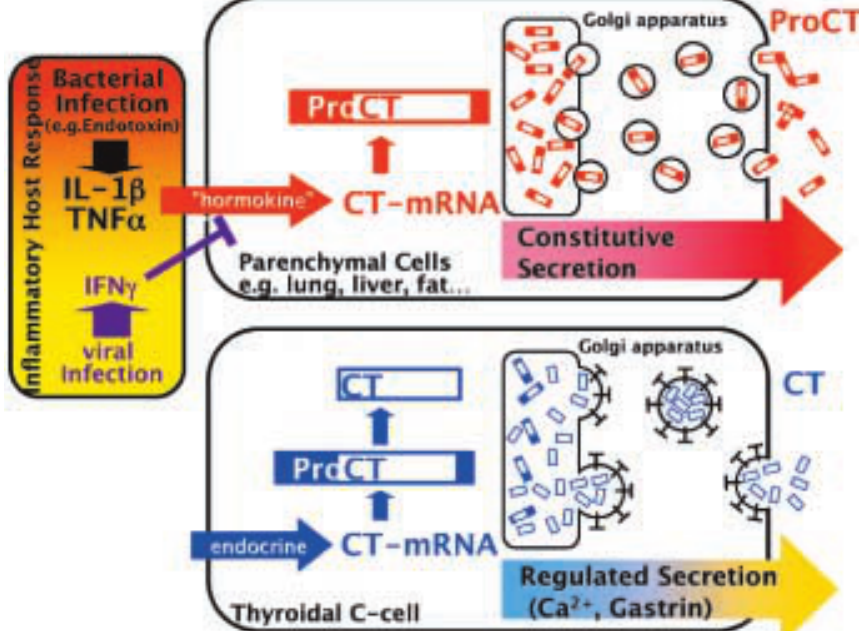
Schematic diagram of CALC I expression in adipocytes and thyroidal C cells. In the classical neuroendocrine paradigm, the expression of CT mRNA is restricted to neuroendocrine cells, mainly C cells of the thyroid. Initially, the 116-amino acid pro- hormone ProCT is synthesised and subsequently processed to the considerably smaller mature CT. In sepsis and inflamma- tion, both proinflammatory mediators and bacterial toxins induce CT mRNA, which can be attenuated by interferon g . In contrast to thyroidal cells, parenchymal cells (eg liver, kidney, adipocytes and muscle) lack secretory granules, and hence, unprocessed ProCT is released in a non-regulated, constitutive manner. Adapted from